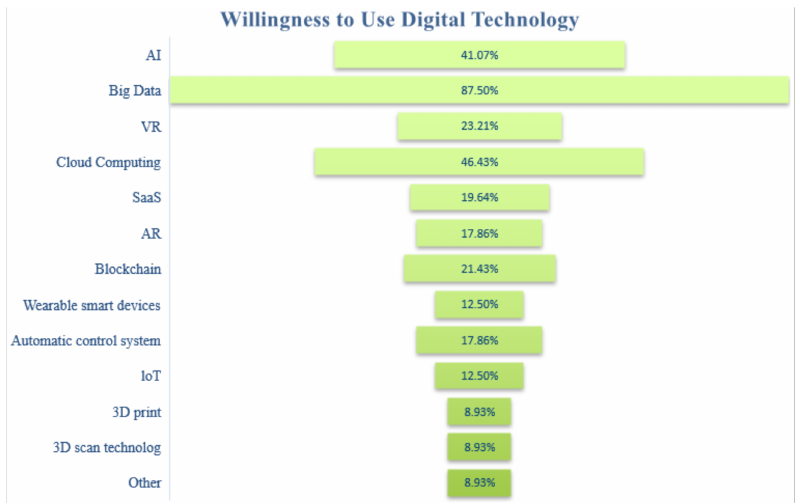
Figure 7. Adoption intention of digital technologies. Note: The figure is mapped based on the questionnaire